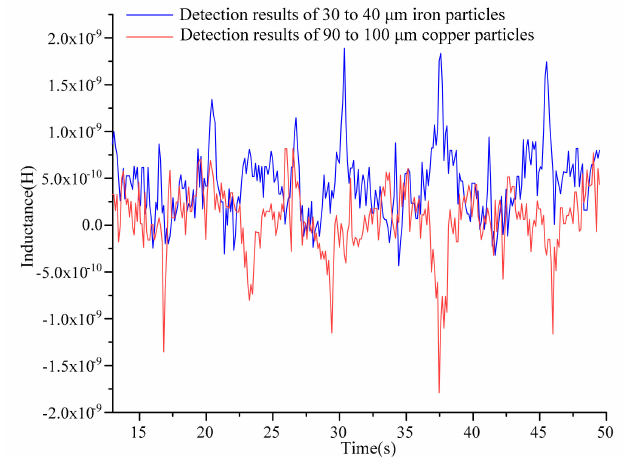
Figure 7. Inductance detection results of 30 to 40 µ m iron particles and 90 to 100 µ m copper particles with silicon steel sheets.